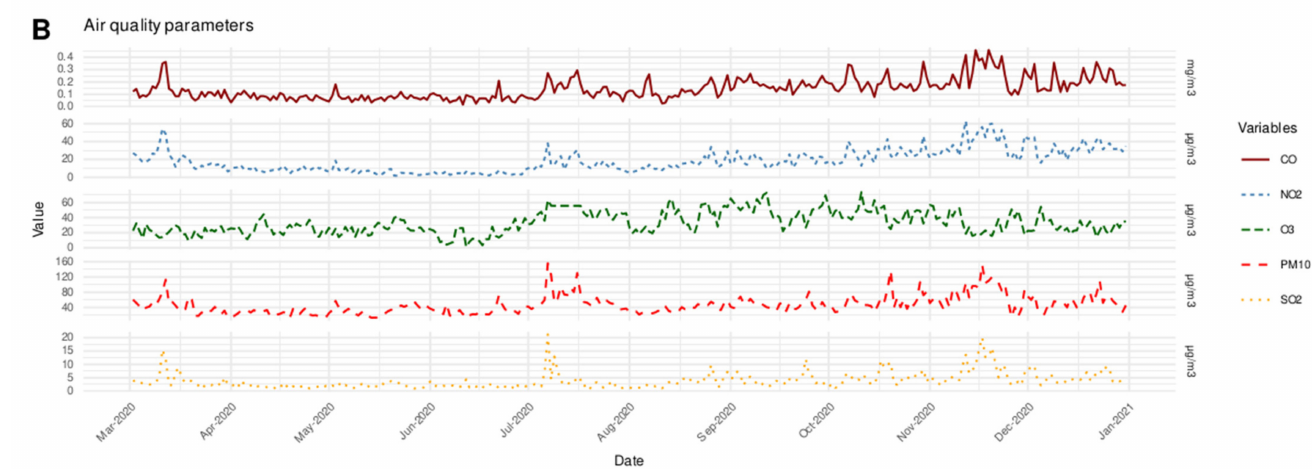
Figure 3. Time series distribution of meteorological ( A ) and air quality ( B ) parameters in Casablanca